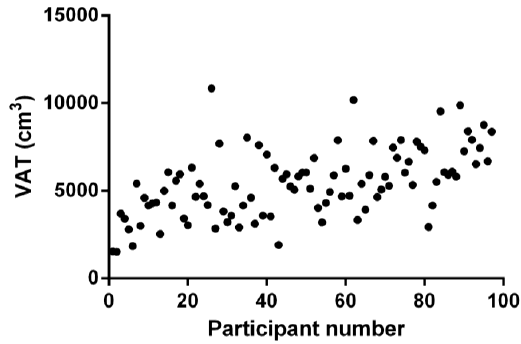
Figure 2. Visceral adipose tissue volume (VAT), as determined by magnetic resonance imaging for each of the postmenopausal women with obesity in this study ( n = 97).